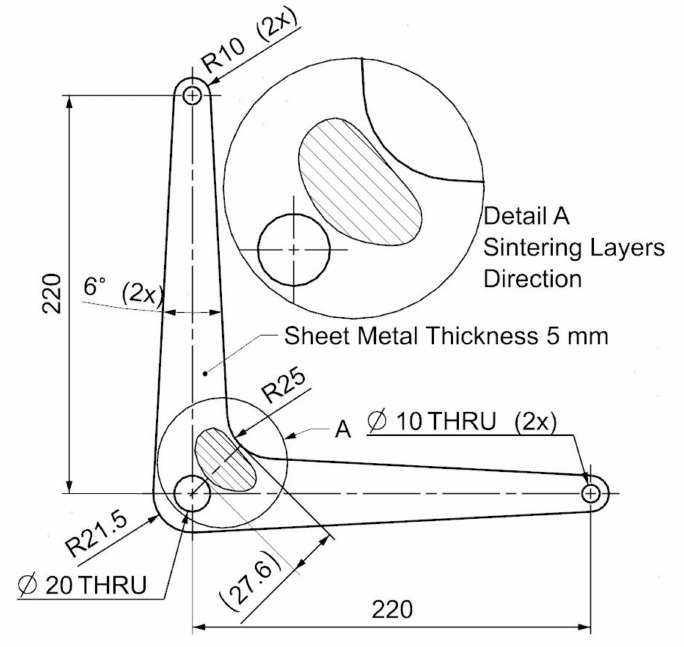
Figure 9. Applying the results of the experiment to the configuration of a real design solution.